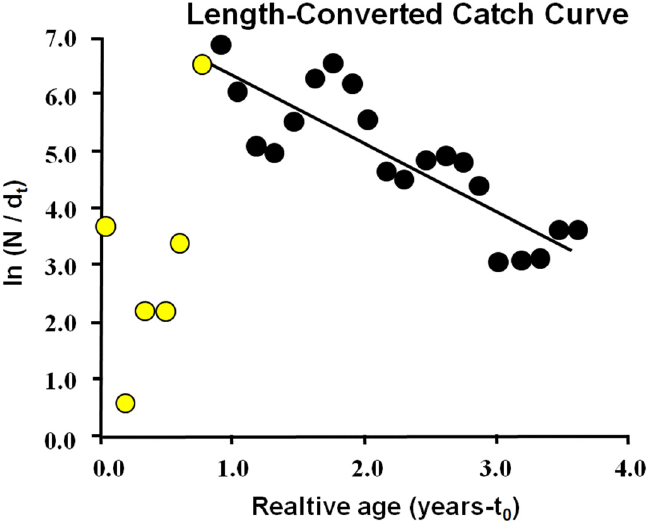
Figure 6. The length-converted catch curve as the determinant of mortality rate of P. penicillatus in Xiamen waters.